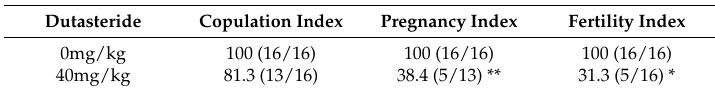
Table 3. Effect of dutasteride treatment on male reproductive indices (%).